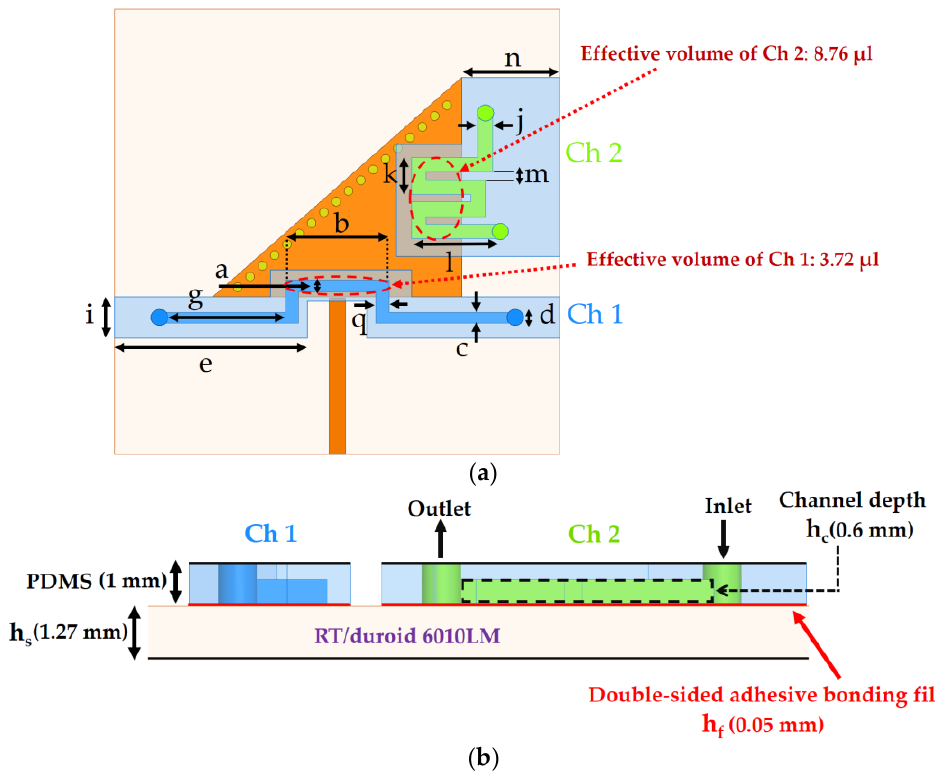
Figure 7. Layout of the proposed TM 02 -mode triangular QMSIW resonator as a dual-detection chemical sensor: ( a ) top view; ( b ) cross-sectional side view. 1 mm-PDMS sheet is considered to model microfluidic channels (h c = 0.6 mm) and an adhesive film (h f = 0.05 mm) is used for bonding purpose. The effective volumes of the two channels are estimated and found to differ considerably, as shown in ( a ).